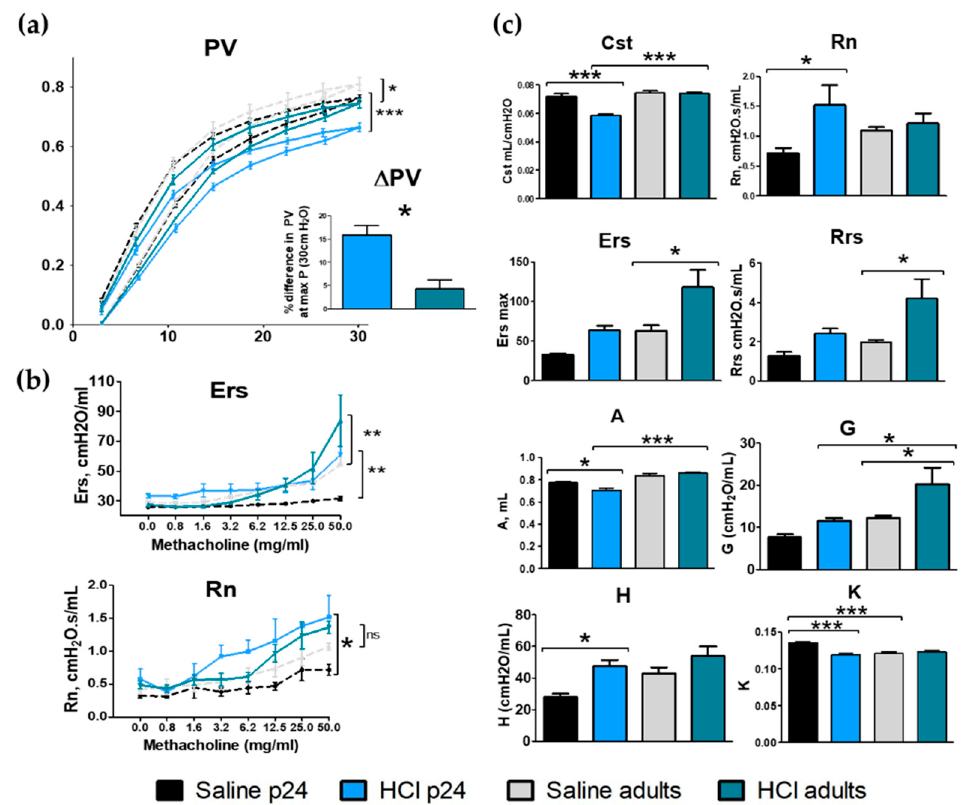
Figure 7. Age-dependent changes in lung mechanics after HCl instillation. ( a ) HCl provokes a downward shift in PV loops, which becomes maximal in young animals. ( b ) Respiratory system elastance (Ers) and Newtonian resistance (Rn) in response to increasing concentrations of aerosolized methacholine in vehicle and HCl-treated young and adult mice. ( c ) Static compliance (Cst), Newtonian resistance (Rn), respiratory system elastance (Ers), respiratory system resistance (Rrs), inspiratory capacity (A), tissue damping (G), tissue elastance (H), and curvature of the PV loops (K) in young and adult mice treated with either HCl or vehicle. Means ± SEM; n = 3–5, * p < 0.05; ** p < 0.01; *** p < 0.001 with one- or two-way ANOVA with Tuckey’s test.